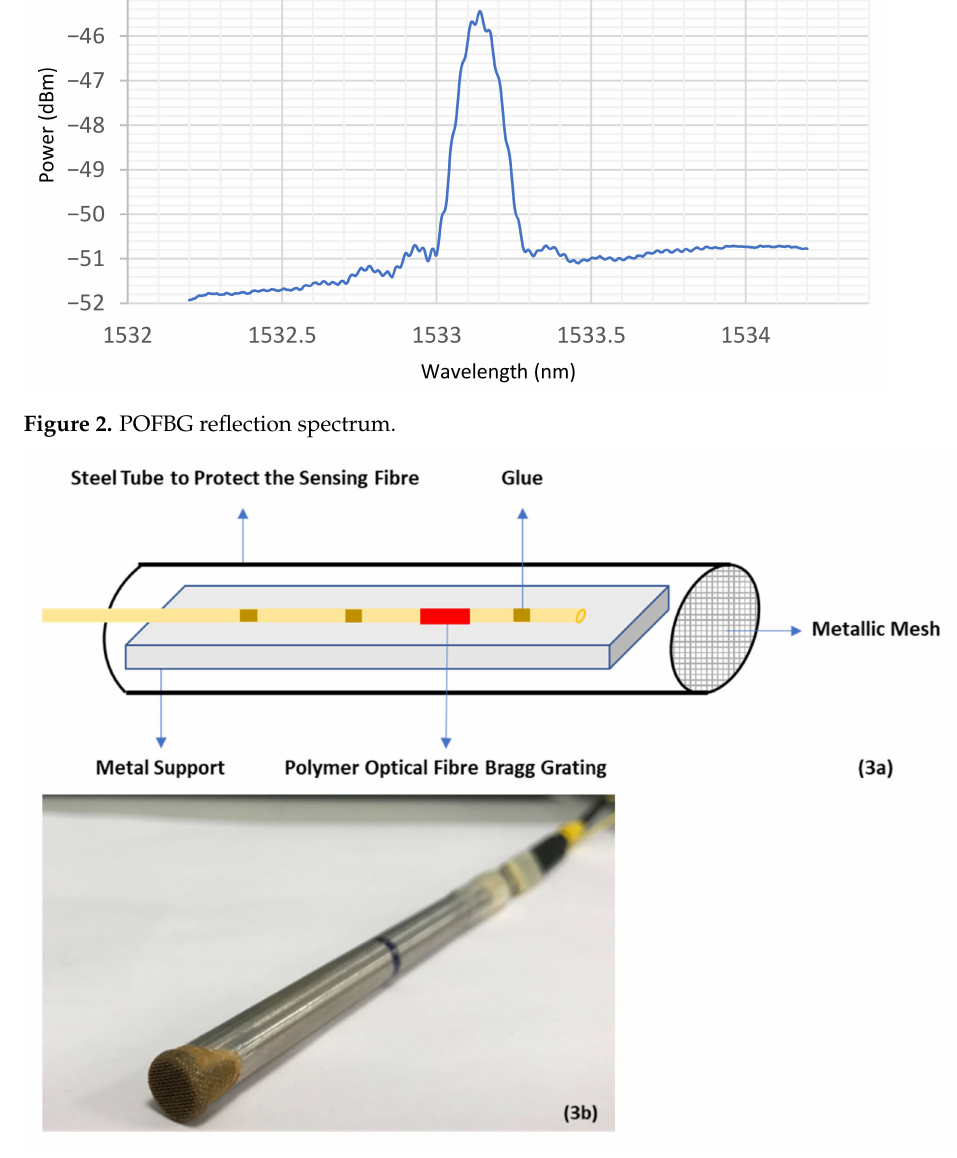
Figure 3. ( a ): Sensor construction, ( b ): The POFBG sensor packaging